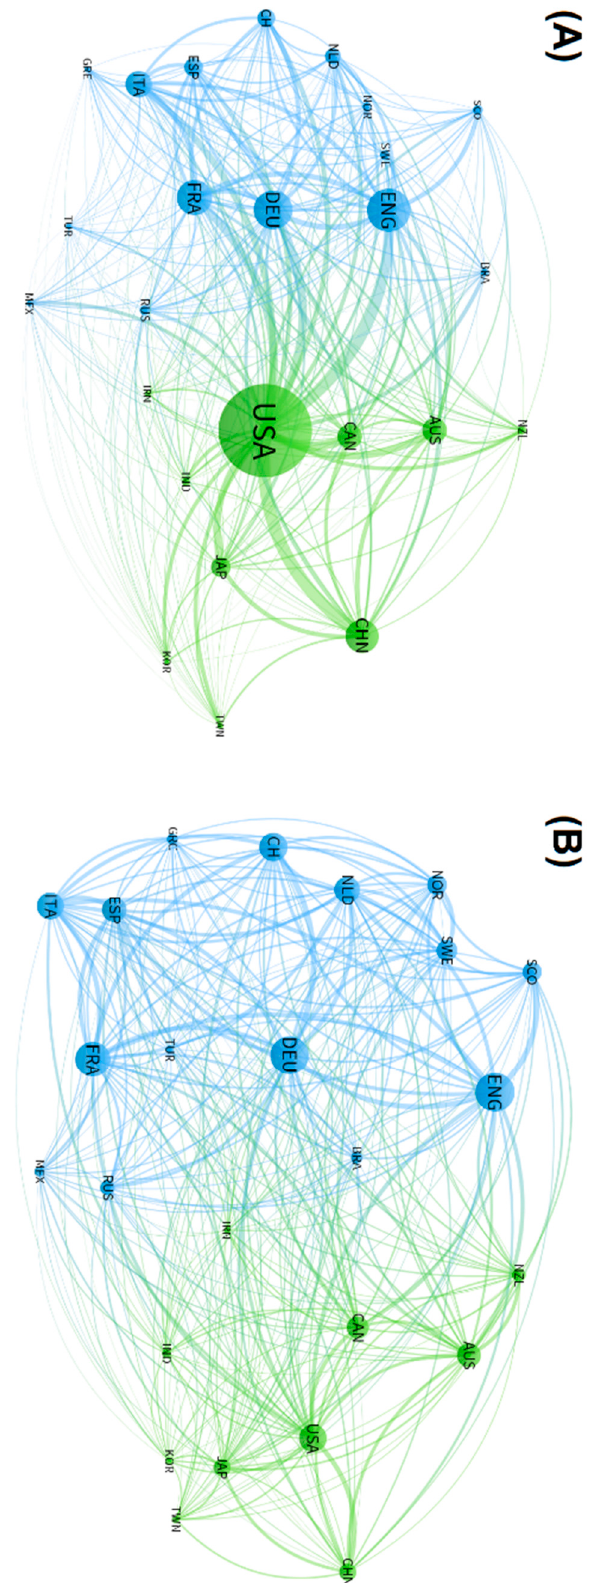
Figure 4. Cooperation between top 25 research countries. Part ( A ) shows absolute number of joint research items between two countries (varying from 9 to 8642); part ( B ) shows relative share of joint research items between two countries on the total number of research items of these two countries (varying from 0.06% to 4.5%). Two apparent clusters are distinguished (see the text).